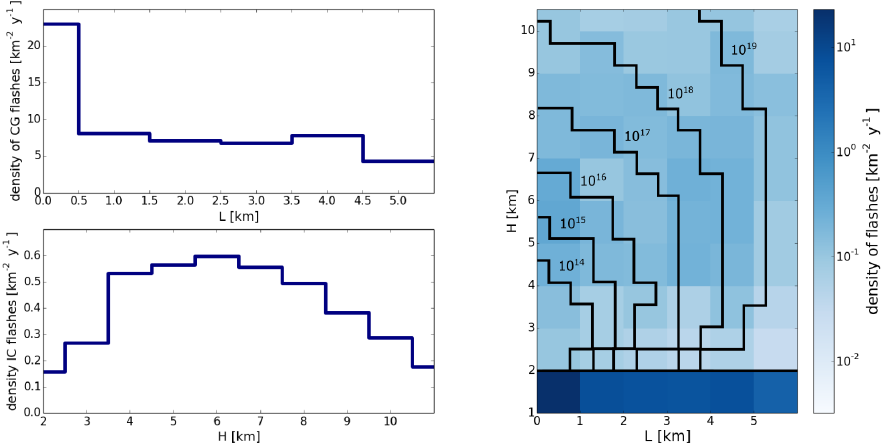
Figure 10. Left : CG ( top ) and IC ( bottom ) lightning flash density in the surroundings of the ground- based Gamma-Flash experiment on Mt. Cimone, obtained by LINET data acquired from 2012 to 2020. CG flashes strongly cluster at L ∼ 0 km, due to orographic reasons, whereas IC lightning peaks at altitudes around H ∼ 6 km a.s.l. Right : 2D lightning flash density, as a function of L and H . The black horizontal line at H = 2 km indicates the average ground elevation in the surroundings of the installation site on Mt. Cimone, marking the region where CG flashes take place. The black stepped contours represent the boundaries of the spatial regions in which TGFs can be detected by the ground-based Gamma-Flash experiment, obtained in Section 5 for α = 40 ◦ and different values of N 0 . Table 1. Expected yearly number of lightning discharges in the Gamma-Flash detectability regions.